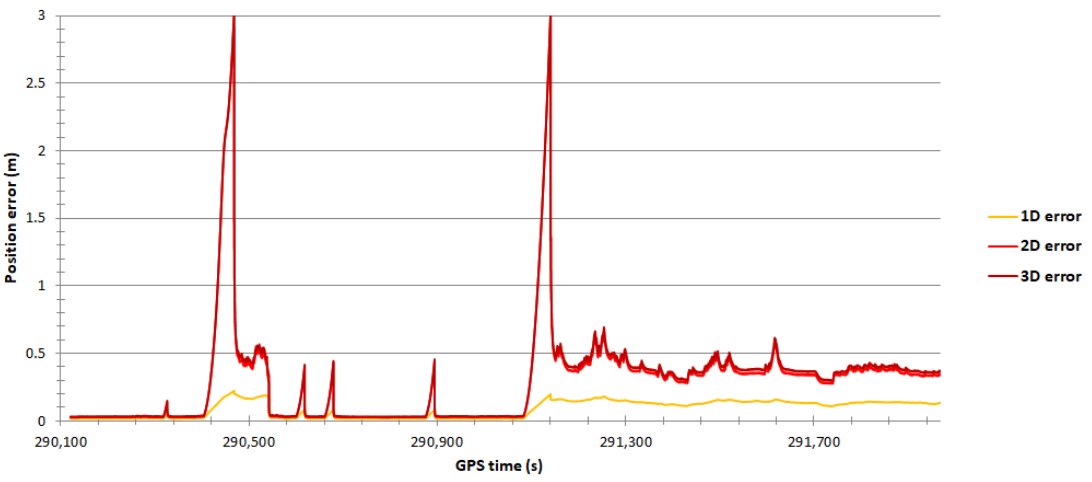
Figure 10. Variability in position errors recorded by the GNSS/INS system in the RTK mode in sec- tion no. 2.